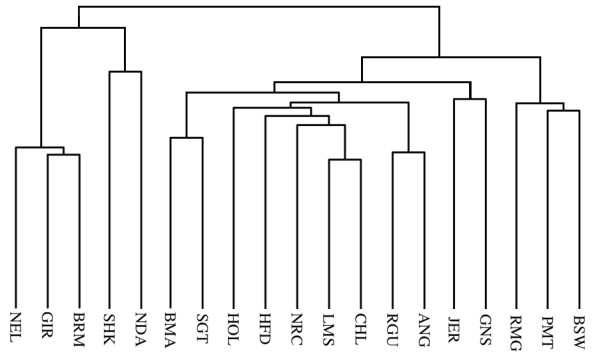
Dendogram Based on Haplotype Sharing Distance. Dendrogram based on genetic distance calculated from haplotype sharing.